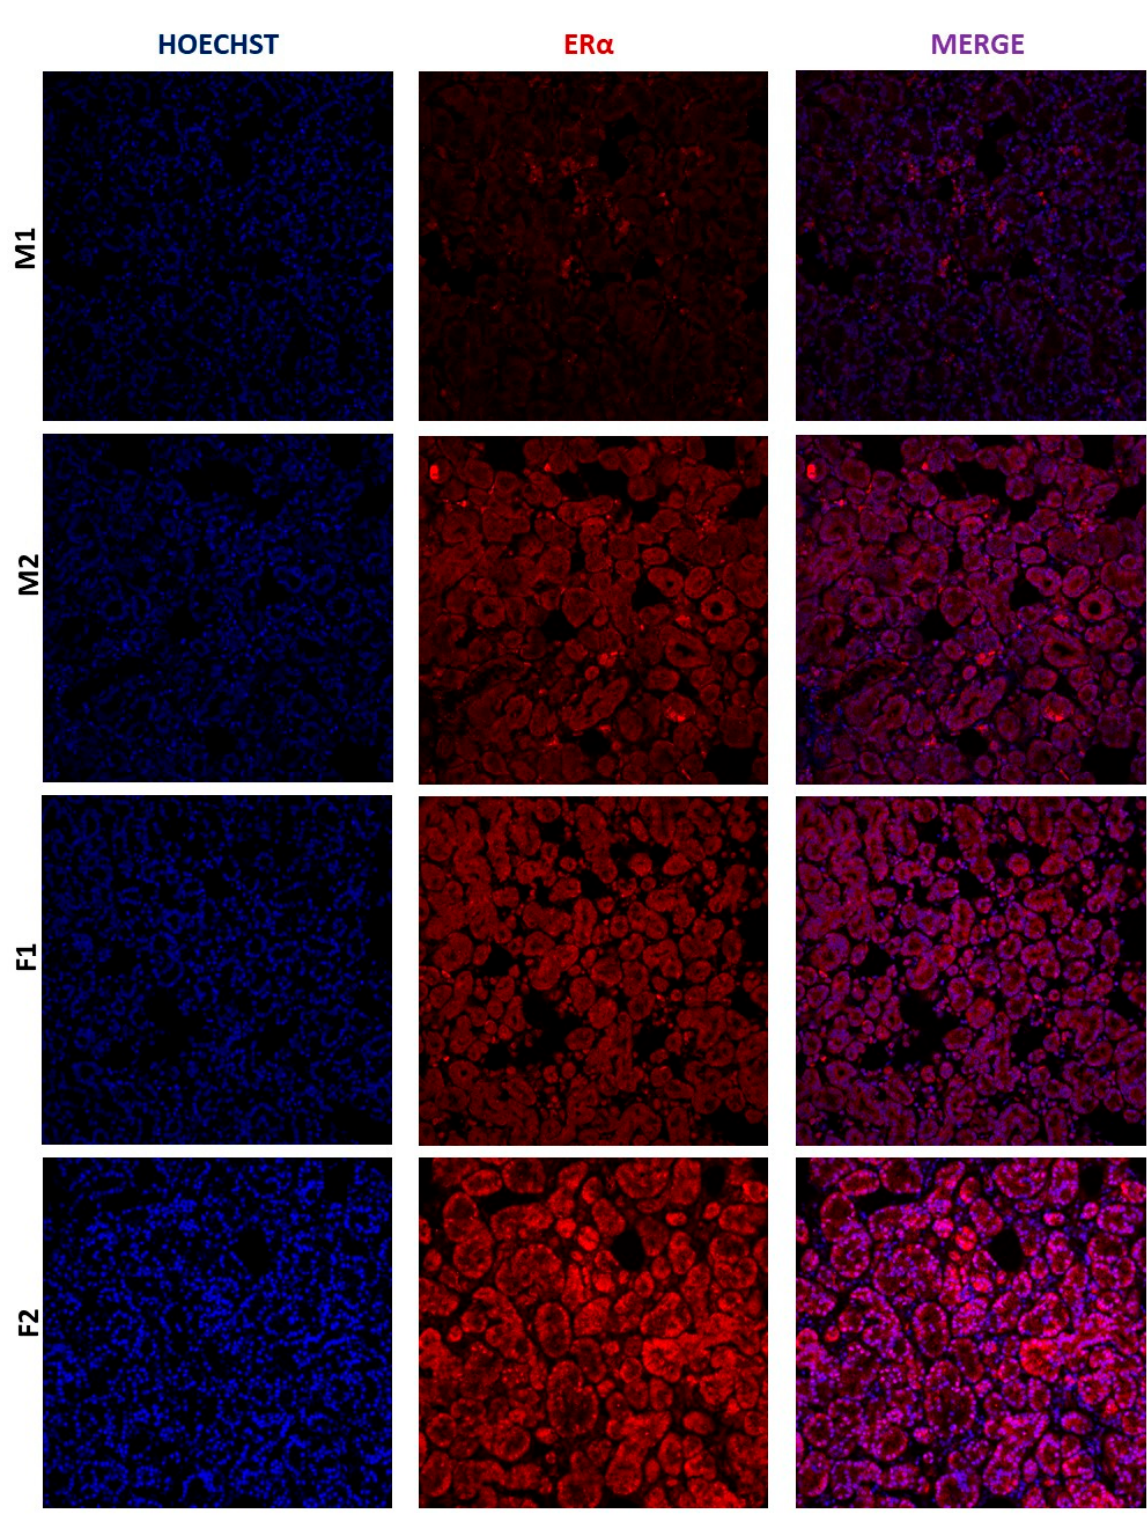
Figure 5. ER α expression in the human lacrimal gland, magnification 20 × . (M1—male lacrimal gland sample 1, M2-male lacrimal gland sample 2, F1—female lacrimal gland sample 1, F2—female lacrimal gland sample 2).